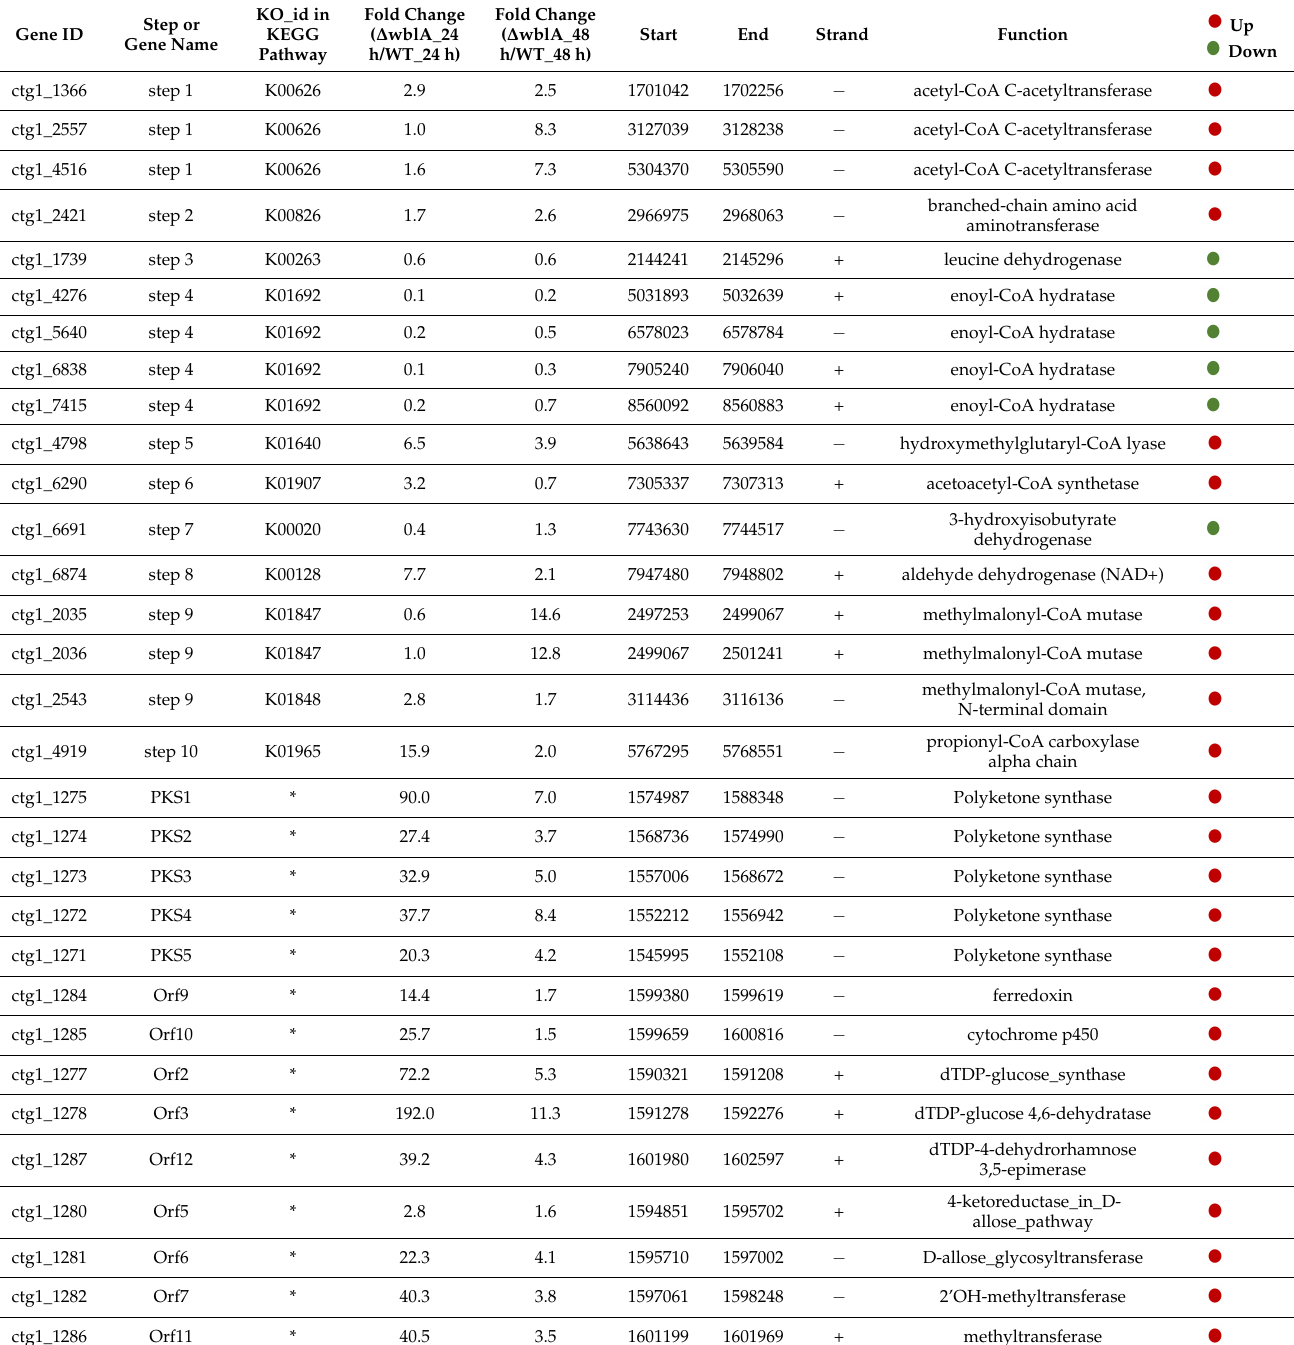
Table 2. Differentially expressed genes in the biosynthesis of tylosin analogue compounds (TACs). Gene